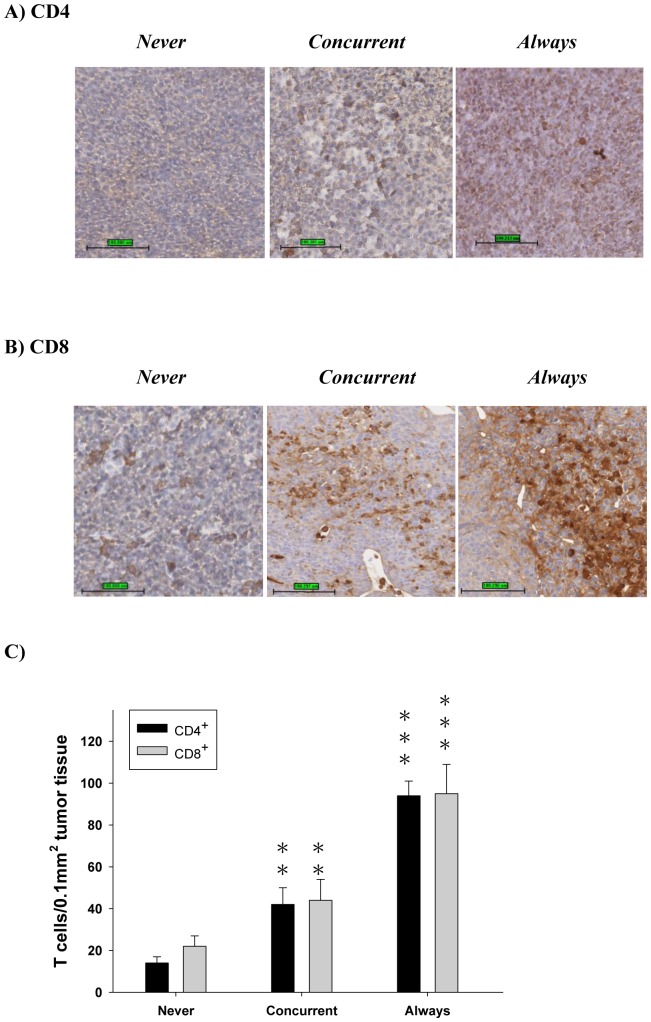
Immunohistostaining of infiltrating CD4+ and CD8+ T cells in tumor tissues of mirtazapine-treated, i.e. concurrent and always, and never mice.(A) CD4 and (B) CD8 in tumors were performed on day 42 post tumor inoculation. Magnification 200 ×. (C) Quantification of CD4+ and CD8+ T cells. (n = 3, **p<0.01 and ***p<0.001 as compared to those of never).